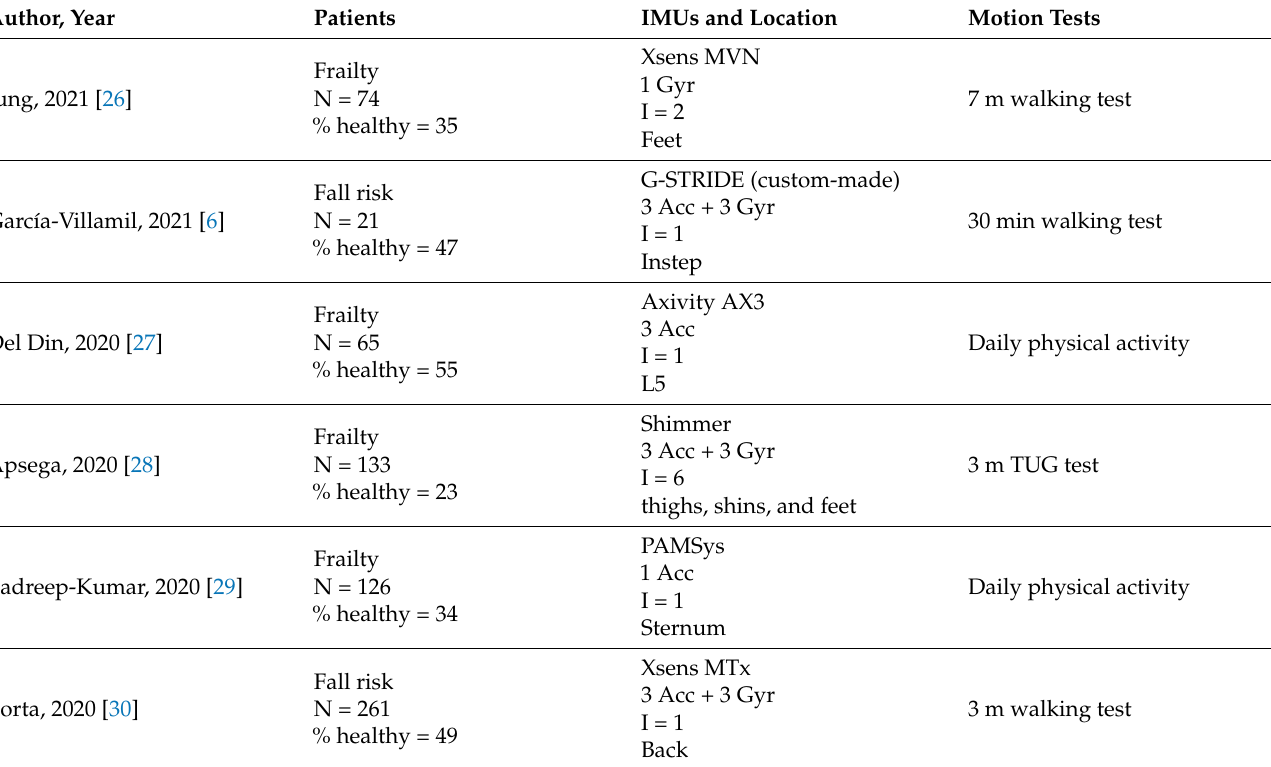
Table 3. Summary of articles included: author, year; patients: medical condition, number of patients (N), and percentage of healthy patients; sensor and location: model, inertial axes used, number of IMUs (I), and location; tests. Note that L3 and L5 correspond to the 3rd and 5th Lumbar vertebra,